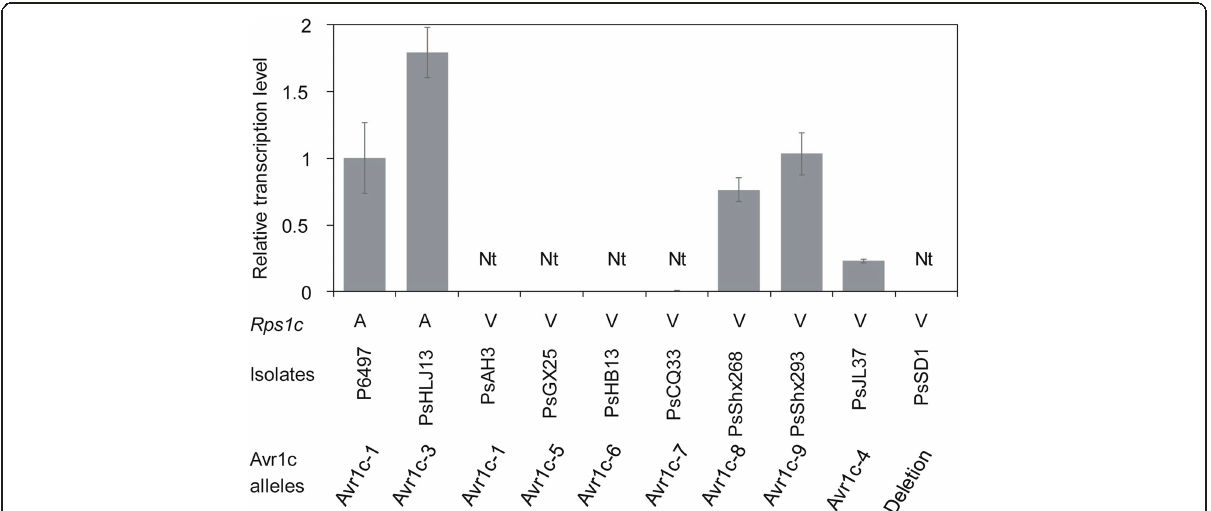
Fig. 4 Expression levels of Avr1c alleles determined by RT-qPCR. The samples at infection stages at 0.5, 1.5, 3, 6, 9, and 12 hpi were collected and mixed. The RNA of the merged samples were extracted to conduct RT-qPCR. The error bars were from three independent replicates. PsSD1 ( Avr1c deleted) as the control. Nt, no transcription. A, the isolates were avirulent on Rps1c ; V, virulent on Rps1c